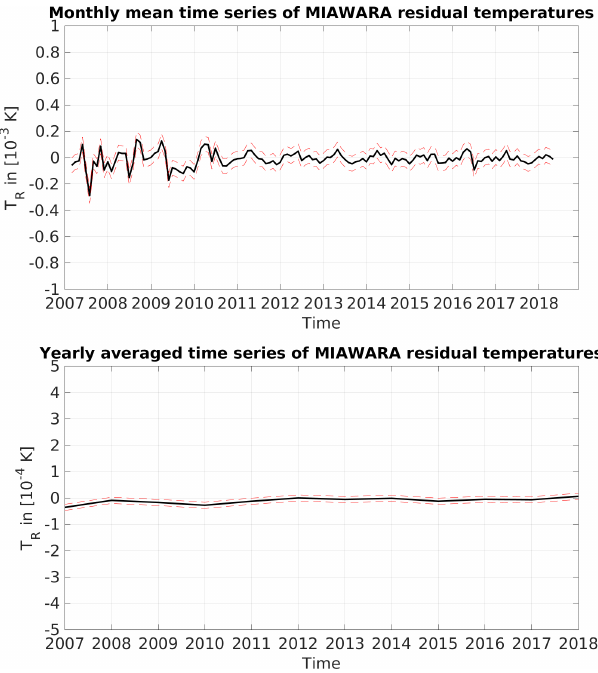
Figure 3. Monthly and yearly averaged MIAWARA T R residuals within the time period of the trend analysis (April 2007 to May 2018). The red dashed lines mark the respective standard deviations.